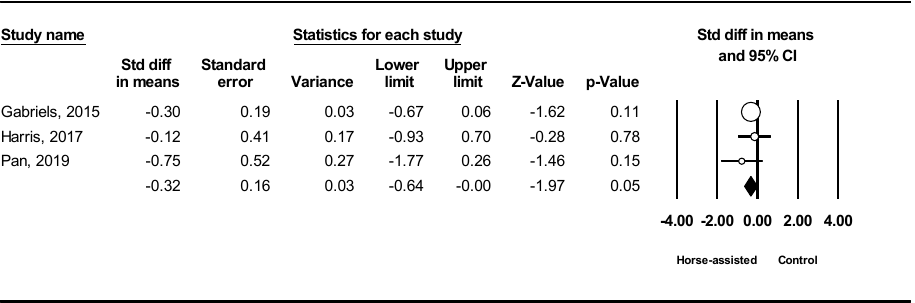
Figure 9. Forest plot showing the effects of horse-assisted therapy vs. control on hypersensitivity [44–46]. The pooled meta-analysis results from the three studies in Figure 10 showed that horse-assisted therapy did not produce a significant improvement in inappropriate speech behavior in children with ASD (SMD = − 0.28, 95% CI [ − 0.59, 0.04], p = 0.08). Figure 10. Forest plot showing the effects of horse-assisted therapy vs. control on inappropriate speech [44–46]. 4. Discussion Our purpose in this study was to use the techniques of a systematic review and meta- analysis to synthesize the findings of previous studies regarding the effects of THR pro- grams on the social interaction and communication skills of children with ASD. We se- lected 4 good-quality studies and 1 fair-quality study from a total of 138 initially identified AAI articles. A total of 240 participants were included and analyzed for this study. The results of the meta-analysis provided evidence that THR programs can considerably im- prove the social interaction and communication skills of children with ASD. Although we